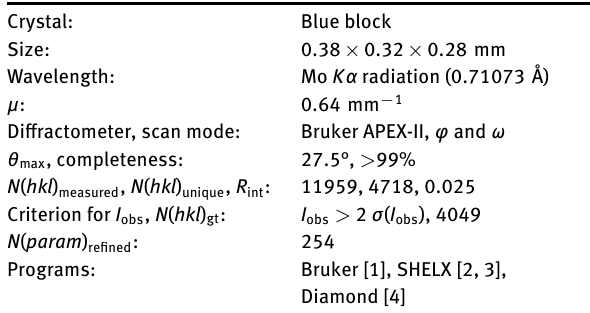
Table 2: Fractional atomic coordinates and isotropic or